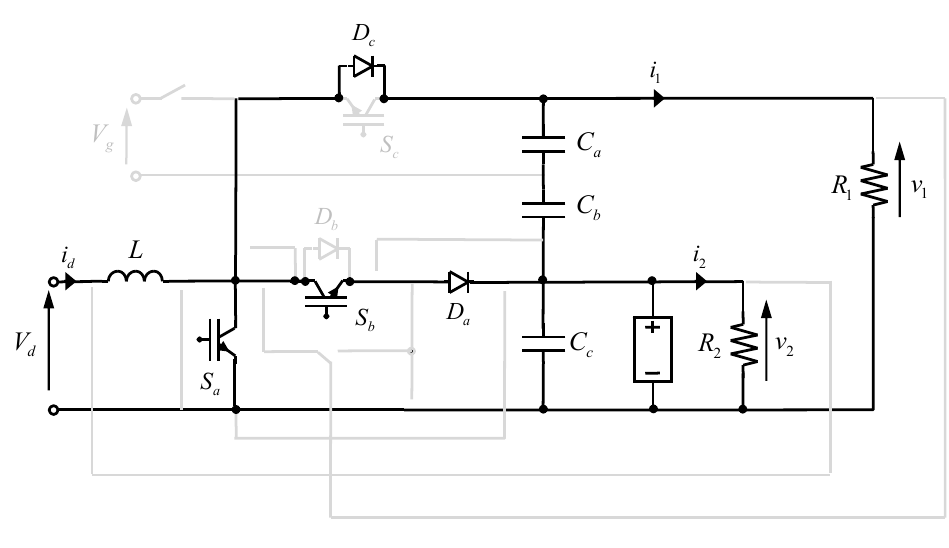
Figure 3. Double-level Boost